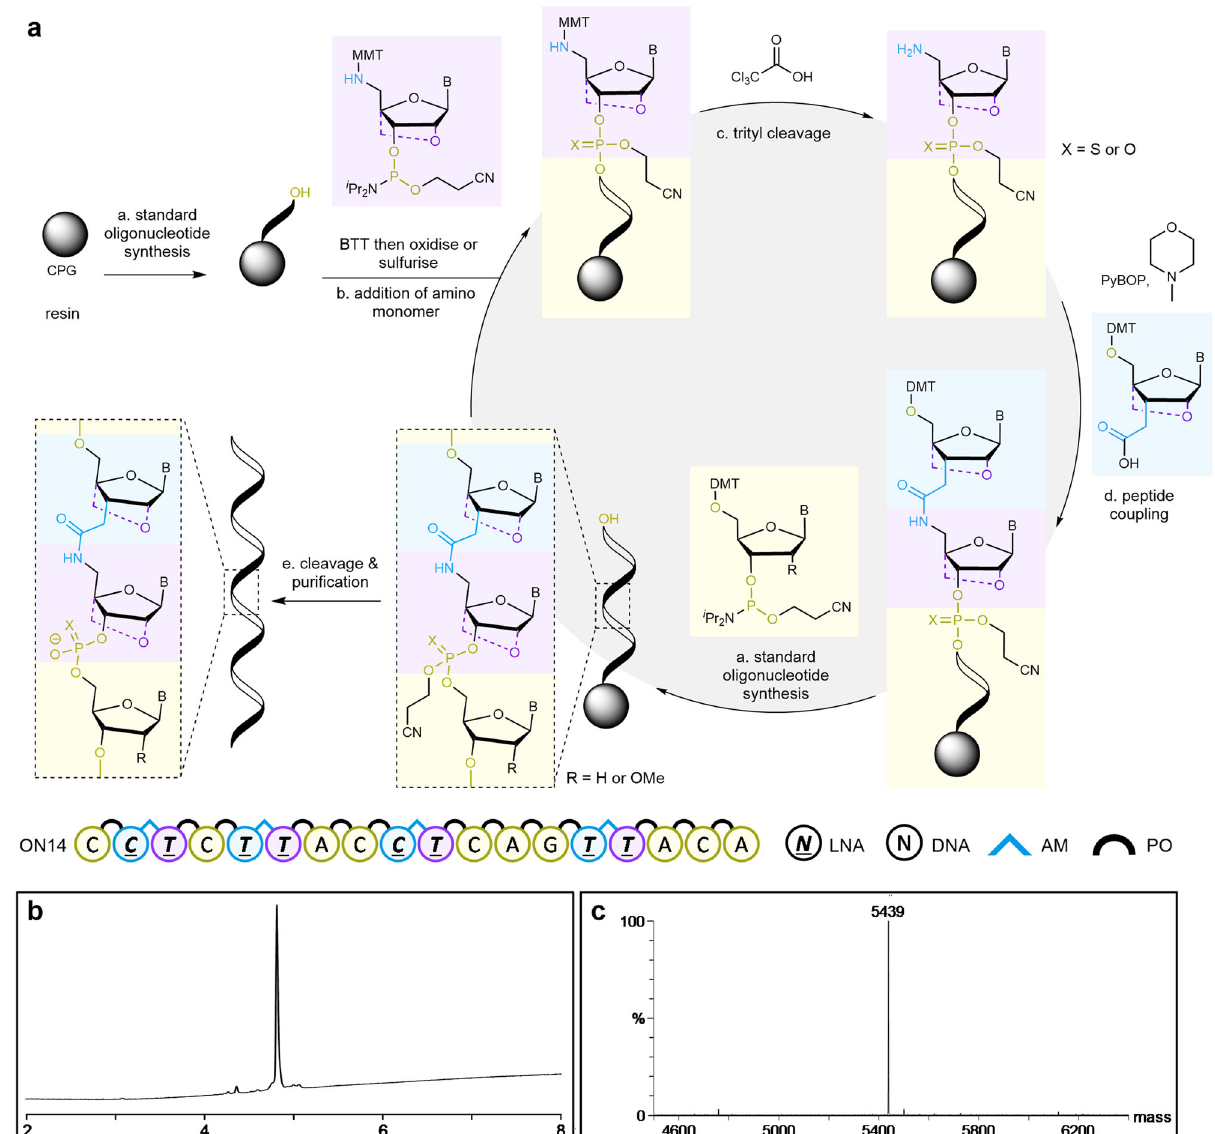
Fig. 3 Synthesis of (LNA)-amide-phosphodiester chimeric oligonucleotides. a Ef fi cient solid-phase synthesis of amide-phosphodiester chimaeras. Dashed lines indicate the presence or absence of 2 ′ -4 ′ -methylene bridge. PyBOP benzotriazol-1-yloxytripyrrolidinophosphonium hexa fl uorophosphate. b Reversed-phase HPLC chromatogram. X-axis = time in minutes. y-axis = absorbance at 260 nm. c Electrospray ES- mass spectrum of a crude LNA-amide chimeric oligonucleotide (ON14). X-axis = mass Y-axis = relative intensity. Required mass = 5438.7 Da, Found mass =